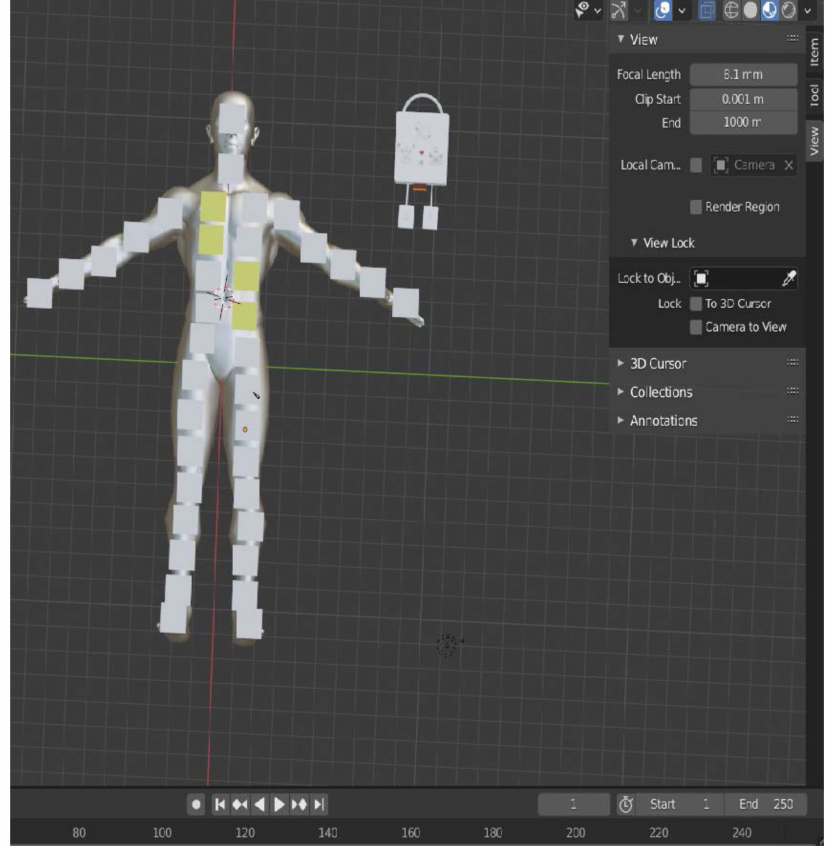
Figure 7. View of shock pad hitboxes from Blender. All hitboxes were made the same color in the final version.